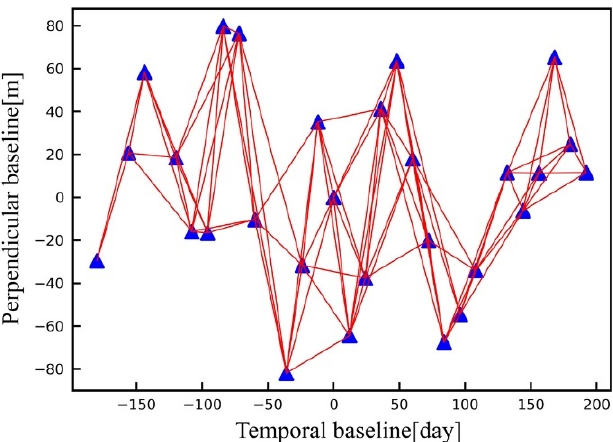
Figure 3. Temporal and perpendicular baselines of Sentinel-1 data.